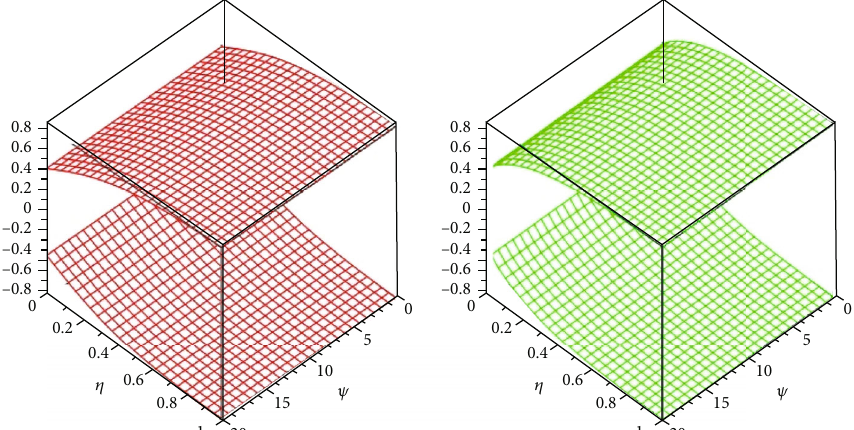
Figure 12: The fi rst graph shows the fuzzy 3D upper and lower fi gure of analytical solution at γ = 1 and the second graph at fractional of γ = 0 : 8 .